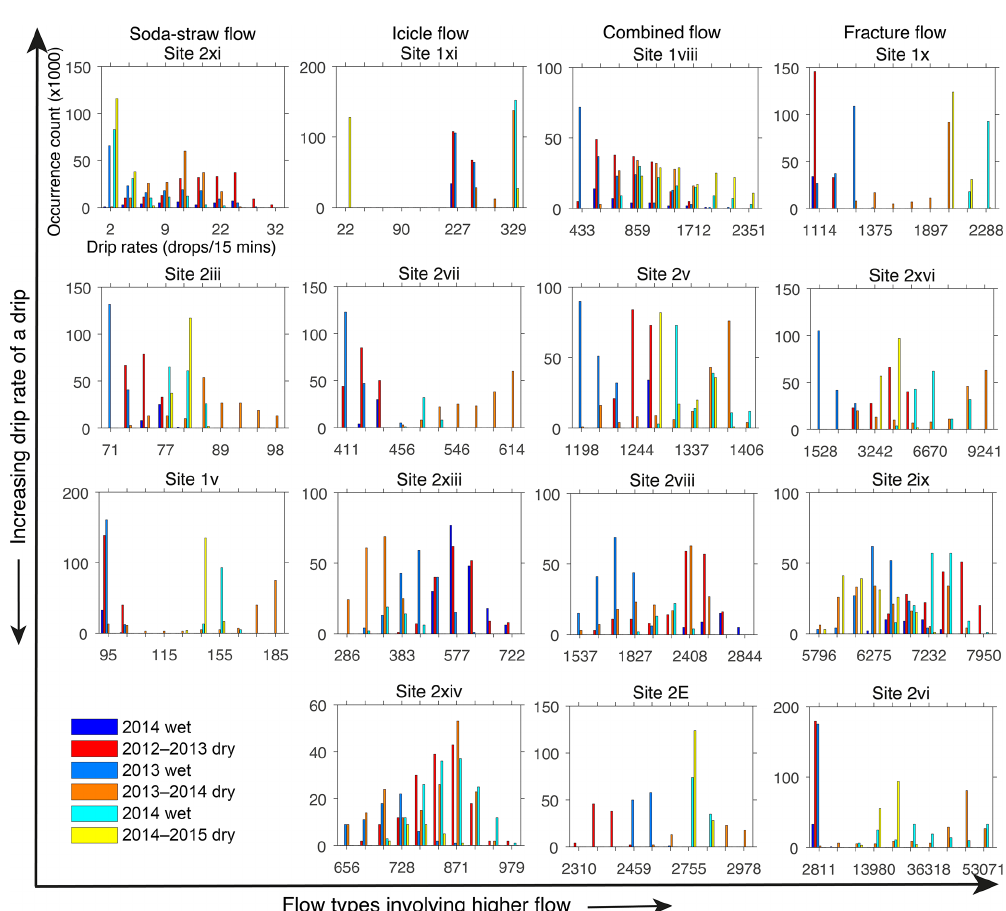
Figure 3. Histogram plots of both chambers’ drip data according to four flow types identified in Mahmud et al. (2016). Each histogram represents the frequencies of the drip counts per day (the axes labels are shown in the first histogram). Bin size is uniform for all plots and the external tick marks in x axes delineate the bin intervals. The legend shows all the seasons over the monitoring period (blue to cyan for wet seasons: April to September; red to yellow for dry seasons: October to March, with the color gradually shifting for different years). The 2012 wet season experienced similar rainfall to the long-term annual mean, whereas 2013 was rather wet and 2014 was a relatively dry year. Histogram data for all sites appear in Fig. S1 in the